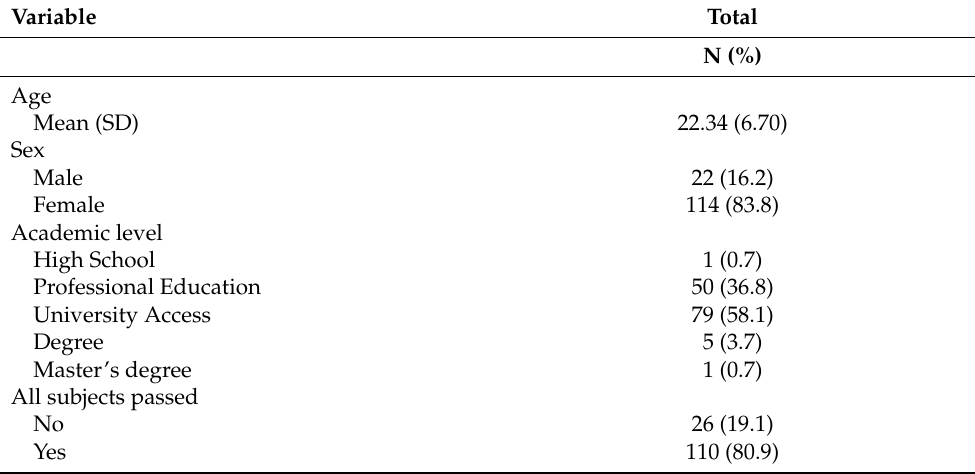
Table 1. Sociodemographic characteristics of the